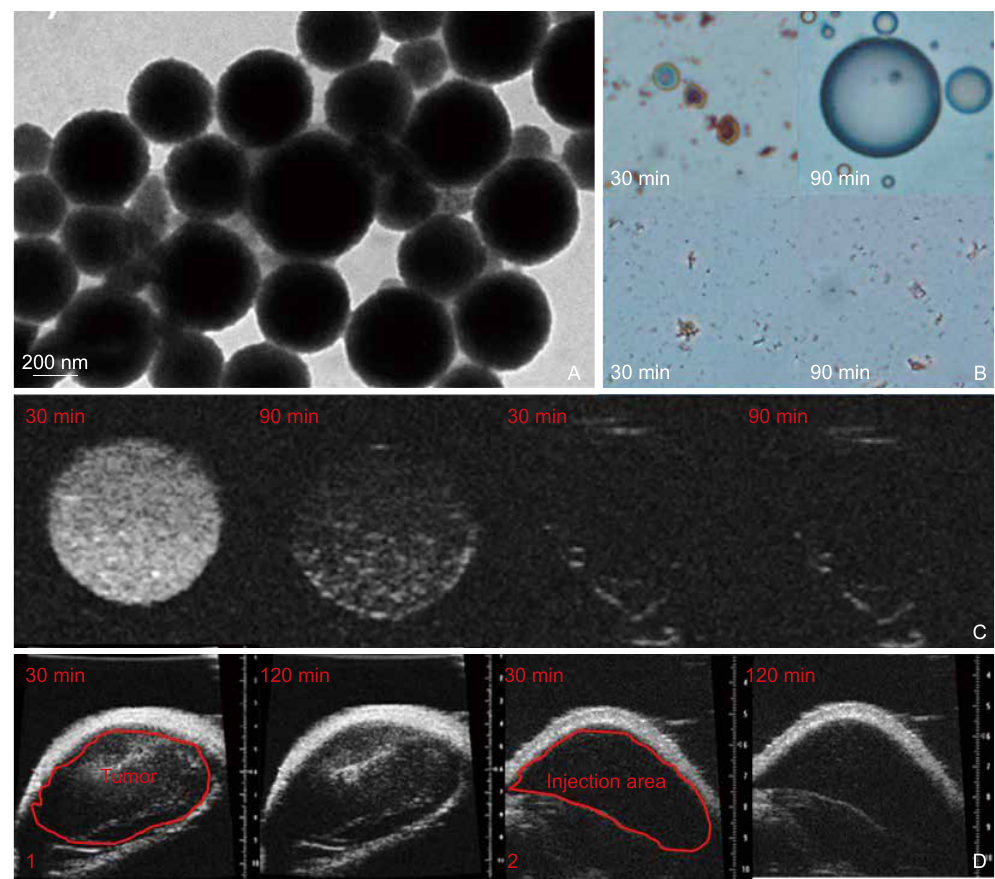
Figure 3 (A) TEM image of DOX-CaCO 3 -MNPs after mineralization for 12 h; (B) Optical micrographs of CO 2 -generating profiles of sub-micron-size aggregates of DOX-CaCO 3 -MNPs incubated in pH = 6.8 (B1) and pH = 7.4 (B2) for 30 and 90 minutes; In vitro ultrasound images of DOX-CaCO 3 -MNPs incubated in pH = 6.8 (C1) and pH = 7.4 (C2) for 30 and 90 minutes; (D1) In vivo ultrasound imaging of the SCC-7 tumor mice by intratumoral injection of DOX-CaCO 3 -MNPs for 30 and 120 minutes; (D2) In vivo ultrasound imaging of the SCC-7 tumor-free mice by subcutaneous injection of DOX-CaCO 3 - MNPs for 30 and 120 minutes.(Reproduced with permission from